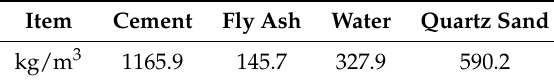
Figure 1. Fibers used for HFRC material cast. Table 1. Mixture for concrete.